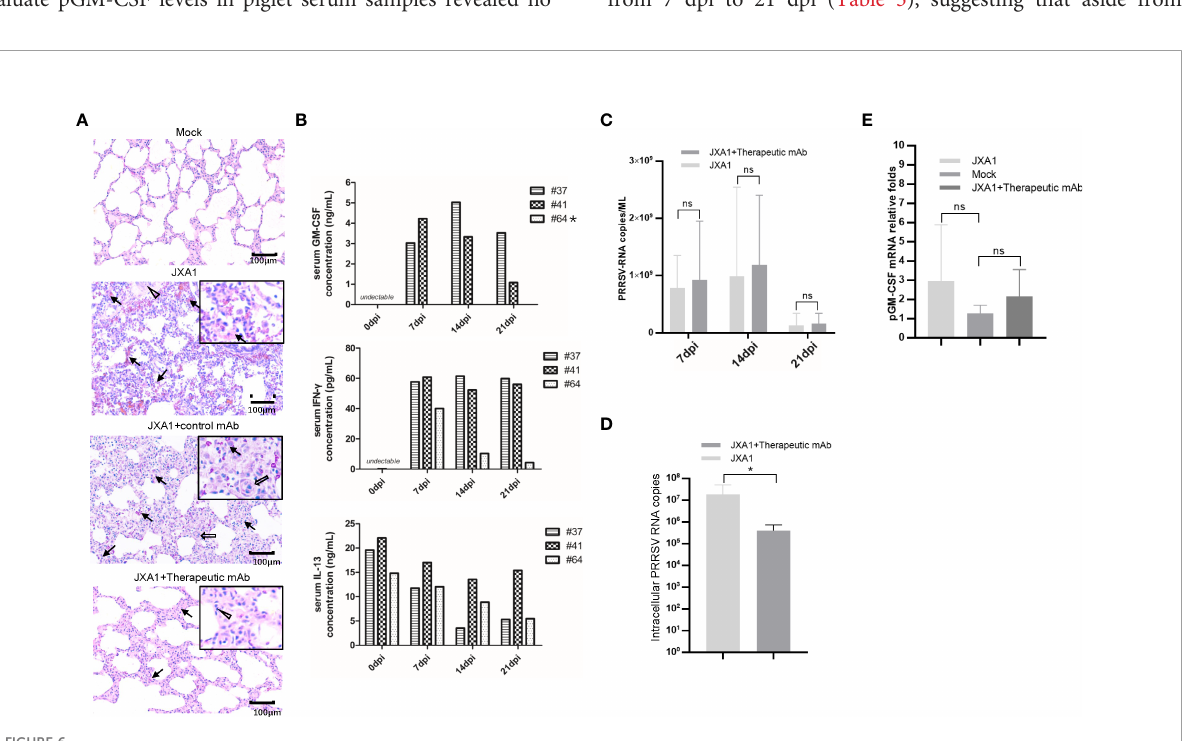
FIGURE 6 Serum pGM-CSF level in PRRSV infected piglets correlated with disease. (A) Lung gross pathological examination via hematoxylin and eosin (H&E) staining was conducted for piglets infected with PRRSV-JXA1(JXA1), PRRSV-infected but therapeutic mAb treated piglets (JXA1 +therapeutic mAb), or PRRSV-infected but control mAb treated piglets (JXA1+control mAb). Lung tissue sample from non-infected piglets (Mock) was includes as control. Arrow indicated thickening of interlobular septal or in fi ltration of in fl ammatory cells around bronchiole or within or around alveolus and bronchus. Triangle indicates in fl ammatory cells, necrotic debris and exfoliated epithelial cells in fi ltrate in the bronchiole. Hollow arrow indicated hemorrhage or in fi ltration of in fl ammatory cells within alveolar septa, and alveolar spaces. (B) Evaluation of serum pGM- CSF, IFN- g and IL-13 concentration from the piglets inoculated with PRRSV-JXA1 but treated with therapeutic mAb at different time points (7 dpi, 14dpi and 21dpi) using home-made pGM-CSF ELISA method and commercial ELISA kits for IFN- g and IL-13. Animal number (64) demonstrated no detectable pGM-CSF was marked by “ * ” . (C) Serum samples from piglets were harvested by TRIzol agent for RNA extraction and reverse transcription. The serum PRRSV-RNA copied numbers was evaluated using Taqman probe in qPCR. (D) PAMs from piglets were harvested by TRIzol agent for RNA extraction and reverse transcription. The intracellular PRRSV-RNA copied numbers was evaluated using Taqman probe in qPCR. (E) PAMs from piglets were harvested by TRIzol for RNA extraction and reverse transcription. The mRNA level of pGM- CSF was evaluated using qPCR. Experiments for above qPCR were repeated at least three times (representing three different animals). All data are presented as mean ± SD and were subjected to Student ’ s t-test. Signi fi cant differences between indicated groups are marked by “ * ” ( p < 0.05), whereas “ ns ” means no